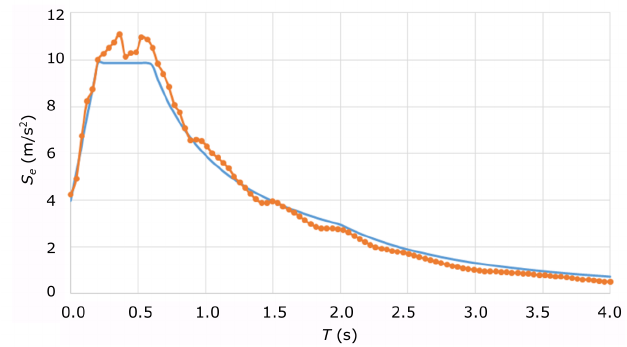
Figure 4. Comparison between the target spectrum (blue continuous line) and the mean spectrum of the 10 generated time series (red dotted line).